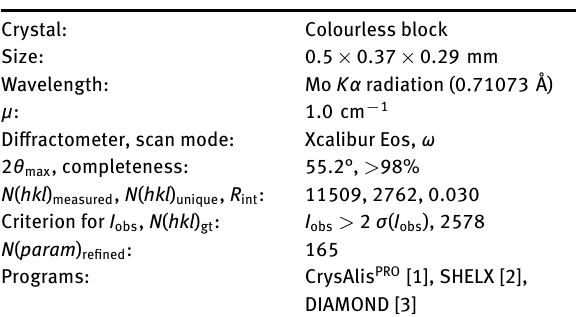
Table 1: Data collection and handling.